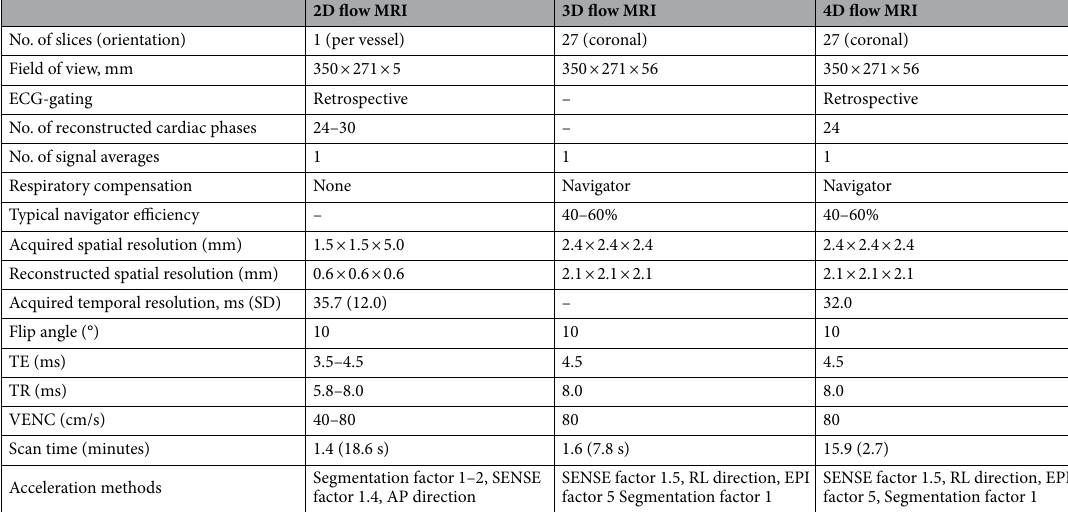
Table 2. MRI acquisition details. SD; standard deviation, ms; milliseconds, mm; millimeter, TE; echo time, TR; repetition time, VENC; velocity encoding, SENSE; sensitivity encoding, AP; anterior–posterior, EPI; echo planar imaging readout, ECG;